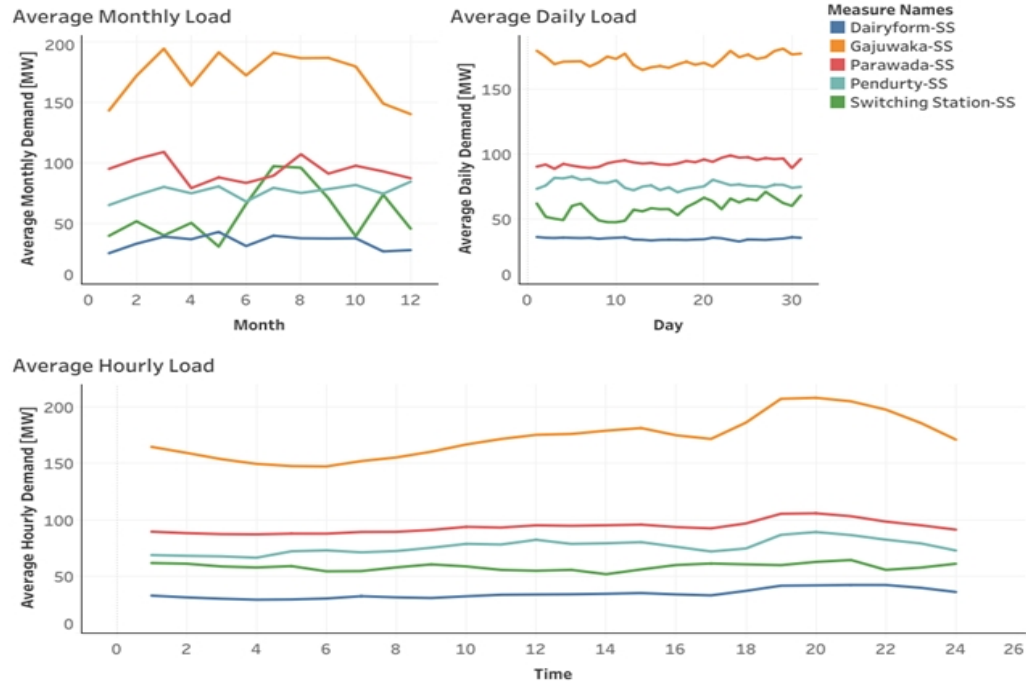
Figure 7. Electric load pattern at the proposed location.